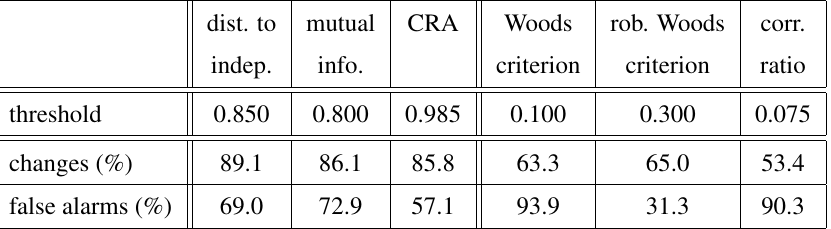
Table 4. Panchromatic/SAR pair: change and false alarm estimates based on manually selected similarity measure thresholds. dist. to mutual CRA info. criterion criterion